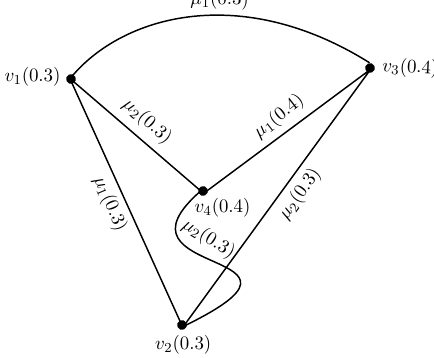
Figure 2. Fuzzy graph structure G = ( σ , µ 1 , µ 2 ) . Figure 2: Fuzzy graph structure G = ( σ, µ 1 , µ 2 )